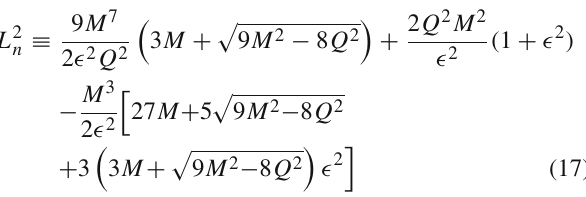
Fig. 2 The charge parameters Q n ( gray curve ), (cid:9) Q ( black solid curve ), and M /(cid:2) ( dashed curve ) as functions of the charge-to-mass ratio (cid:2) of the test